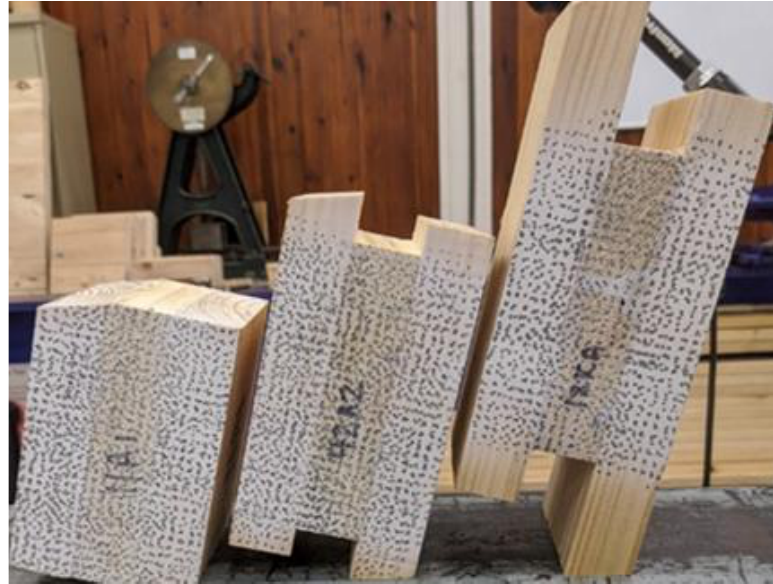
Figure 4. Samples for 0 mm, 20 mm and 57 mm projection.